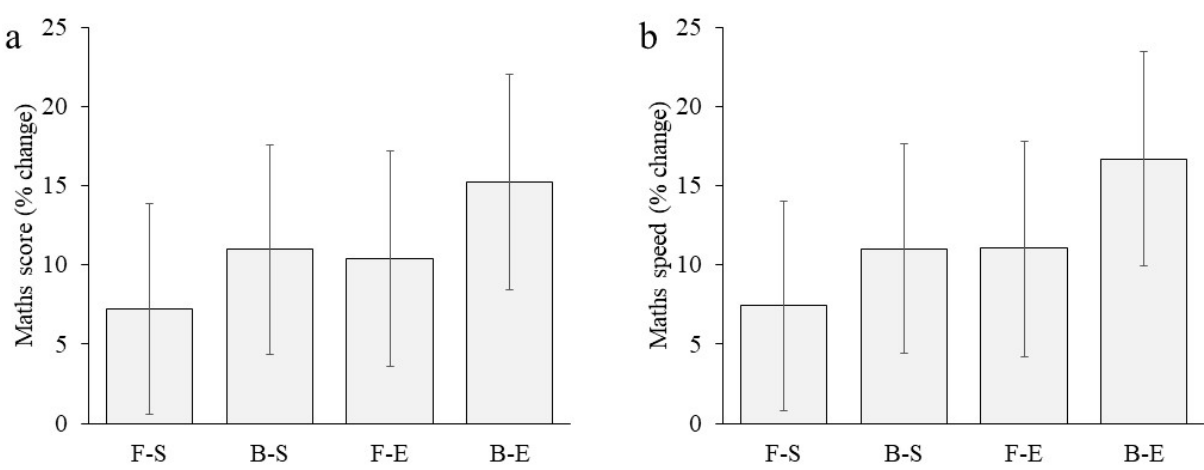
Figure 4. ( a ) Percentage change in mathematics score and ( b ) percentage change in mathematics speed in the fasted and sedentary (F-S), breakfast and sedentary (B-S), fasted and exercise (F-E), and breakfast and exercise (B-E) groups in the 60 s arithmetic test from test-series 1 to test-series 3 . Error bars: 95% Confidence Intervals.